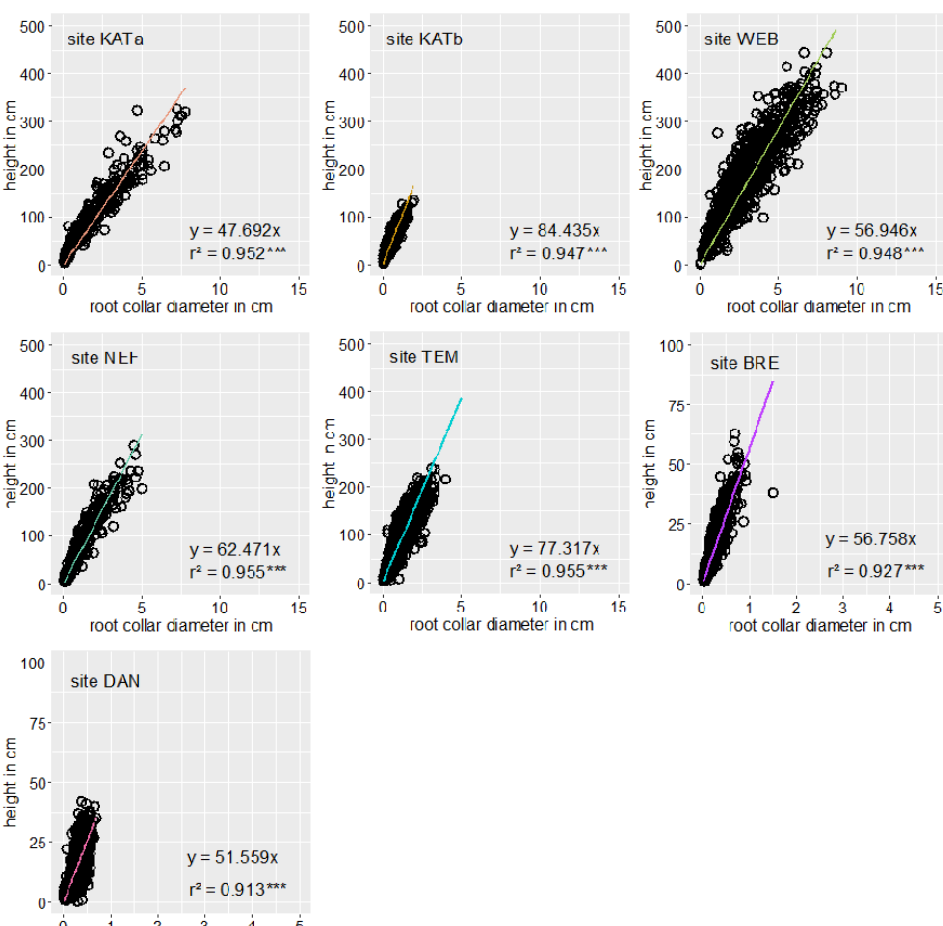
Figure 2. Linear models to show the relationships between the root collar diameter (cm) and height (cm)